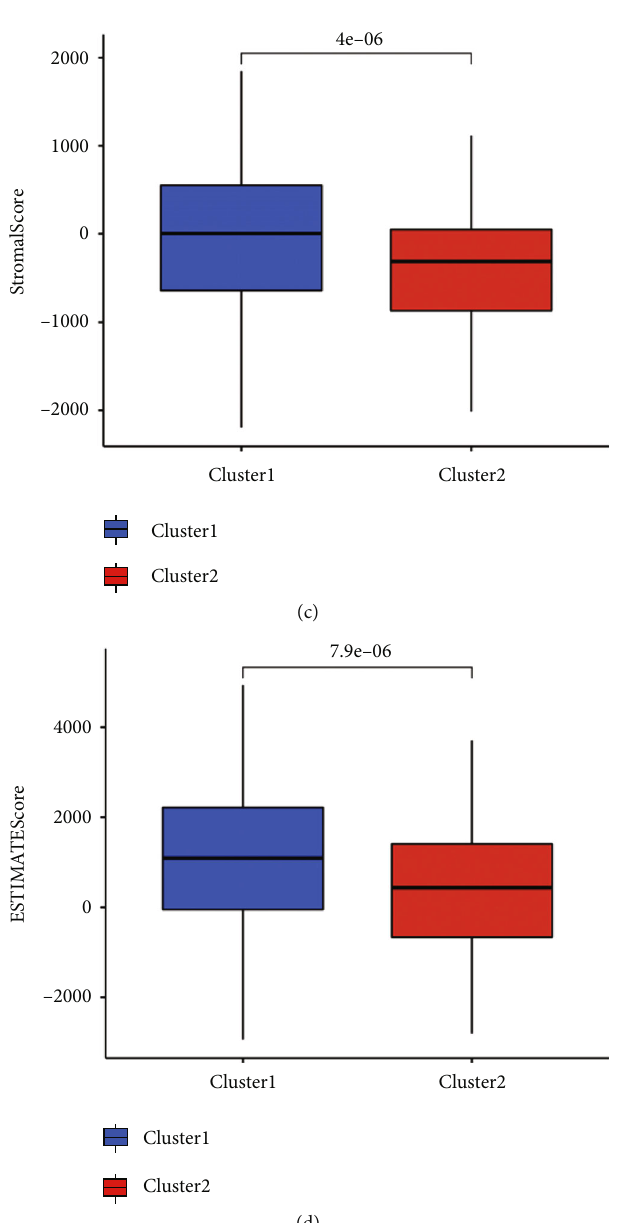
Figure 3: Consensus clustering correlated with distinct immune in fi ltration in LUAD. (a) The immune cell in fi ltration landscape in two clusters of LUAD. (b), (c), and (d) Immunoscore, StromaScore, and ESTIMATEScore in two clusters of